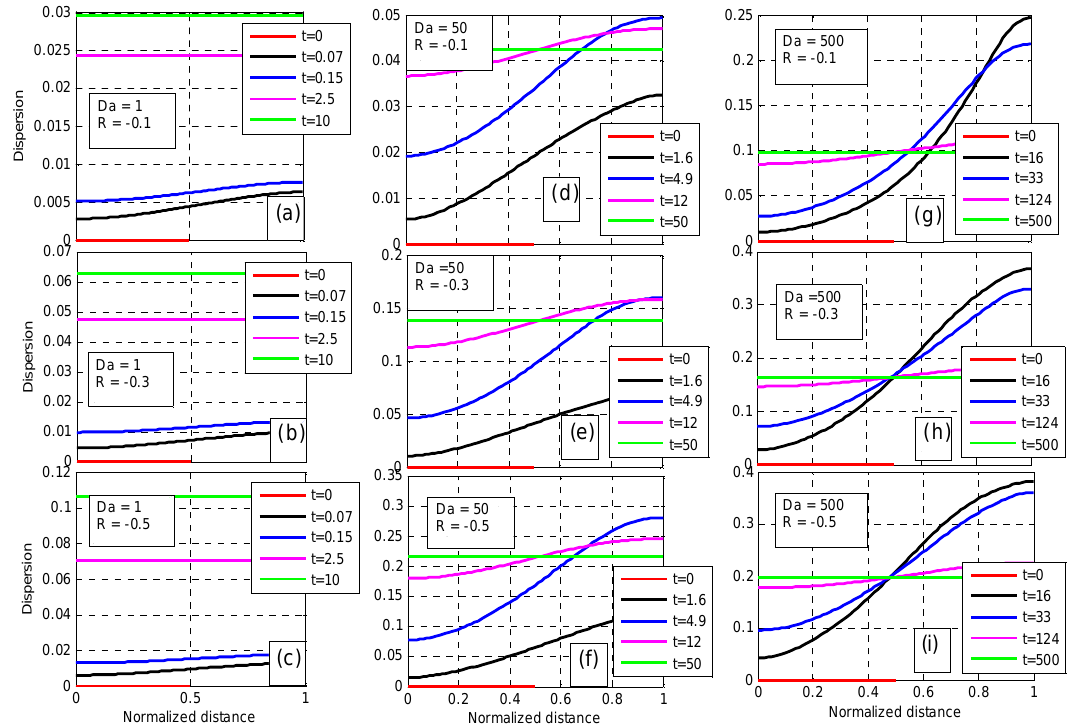
Figure 13. Spatial dependencies of the relative DSD dispersion at different time instances and at different values of Da and different R > − 1.